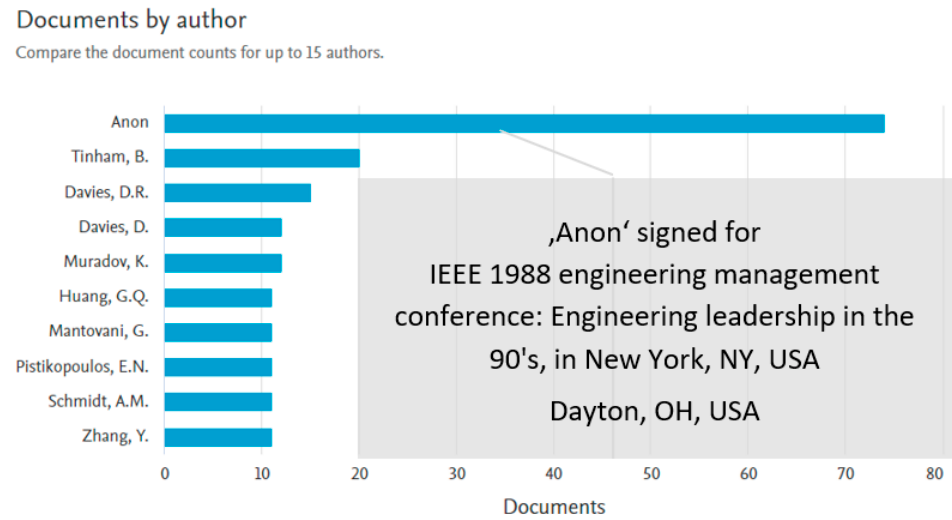
Figure 14. SCOPUS Search: advanced AND production AND control—Documents by Author.